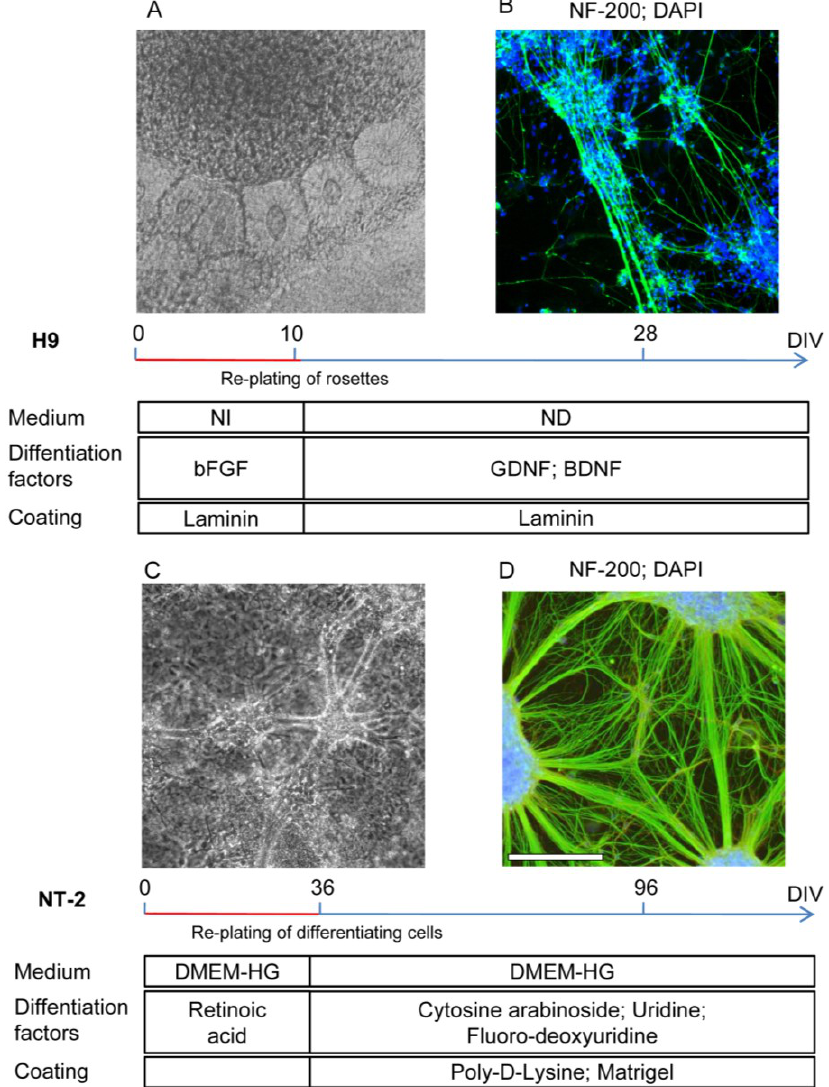
Figure 1. Neural differentiation verified by phase-contrast microscope and immuno-cytochemistry staining. ( A ) Differentiation process triggered the formation of neural rosettes in H9 cell culture (at passage 35), already detectable on 10 DIV (phase contrast, magnification 10×); ( B ) At 28 DIV a dense network of neurites was visualized in H9 cell line by staining against NF-200 (green) and DAPI (blue) (fluorescent microscopy) (at passage 35, magnification 10×). The table presents the process of neuronal differentiation (the applied media, differentiation factors and type of coating; NI-Neural Induction medium, ND-Neuronal Differentiation medium); ( C ) The differentiation towards neuronal phenotype of NT-2 cell line was triggered by the exposure to 10 μM retinoic acid up to 36 DIV (phase contrast, magnification 20×); ( D ) The process of neuronal differentiation of NT2 cells was followed up to 96 DIV. At this time point, groups of neurons (nuclei stained by DAPI, blue) were linked by a dense network of neurites, positively stained against NF-200 (green, fluorescent microscopy, magnification 40×). The table presents the process of neuronal differentiation (the applied media, differentiation factors, and type of coating; NI-Neural Induction medium, ND-Neuronal Differentiation